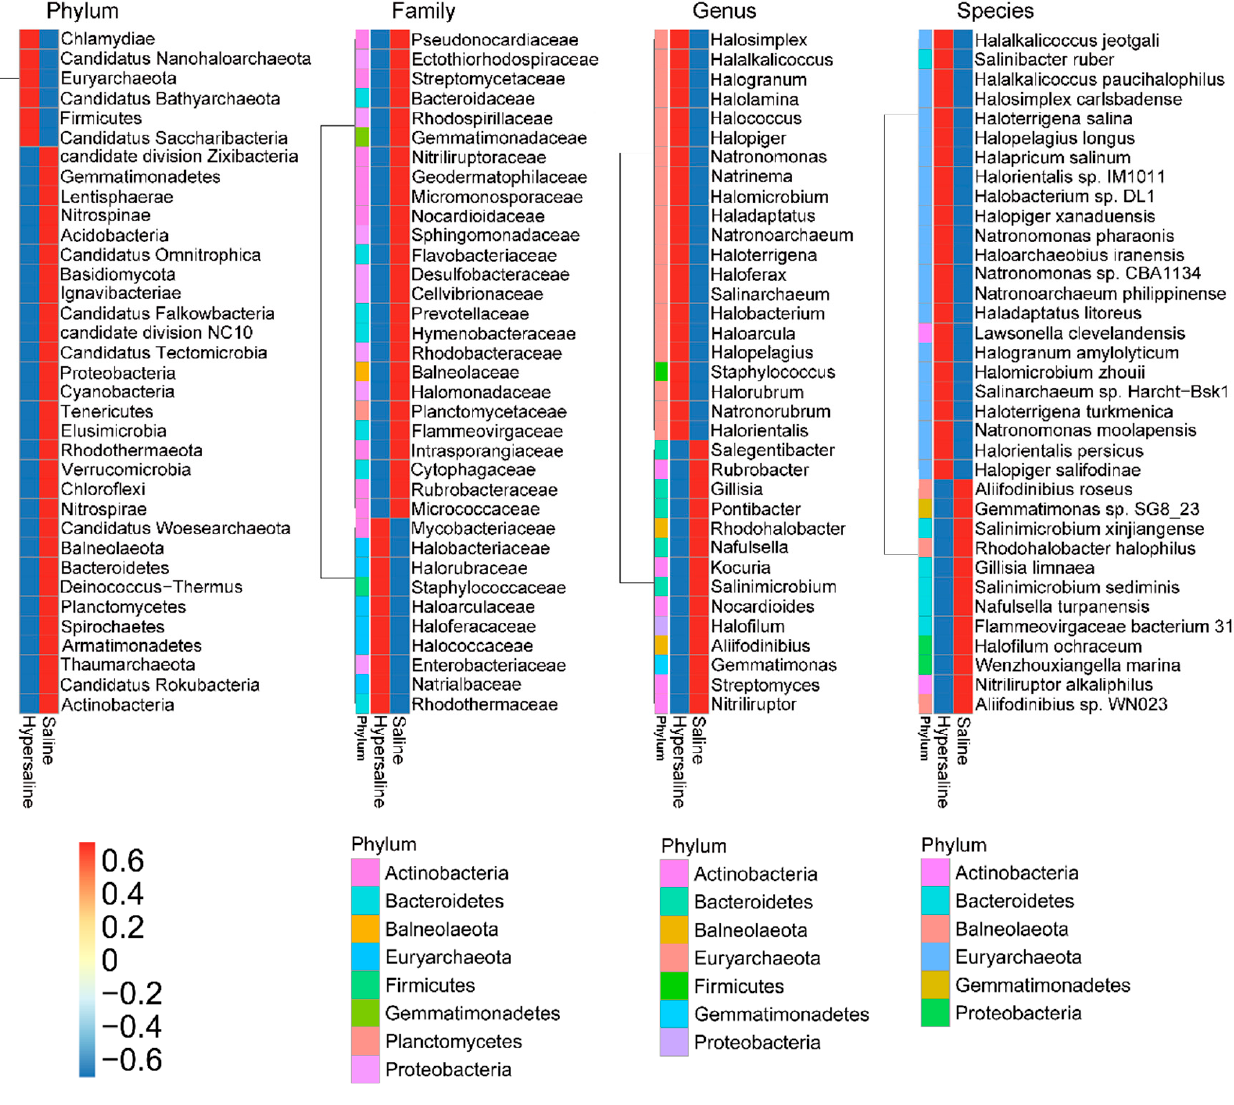
Figure 4. Difference analysis of the most abundant taxonomic groups between saline and hypersaline soils at phylum, family, genus, and species level.